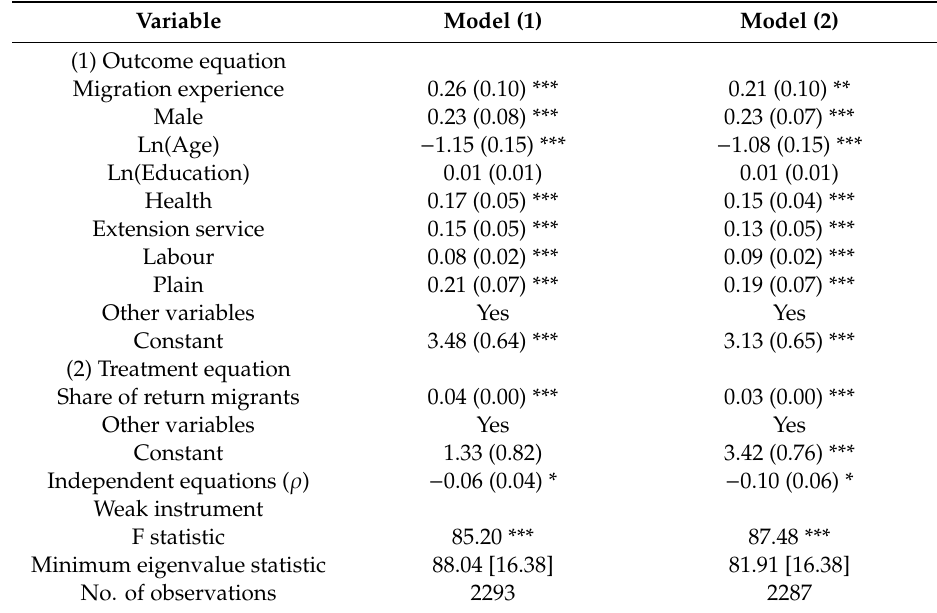
Table 7. Robustness tests for the e ff ects of rural–urban migration experience on arable land use.